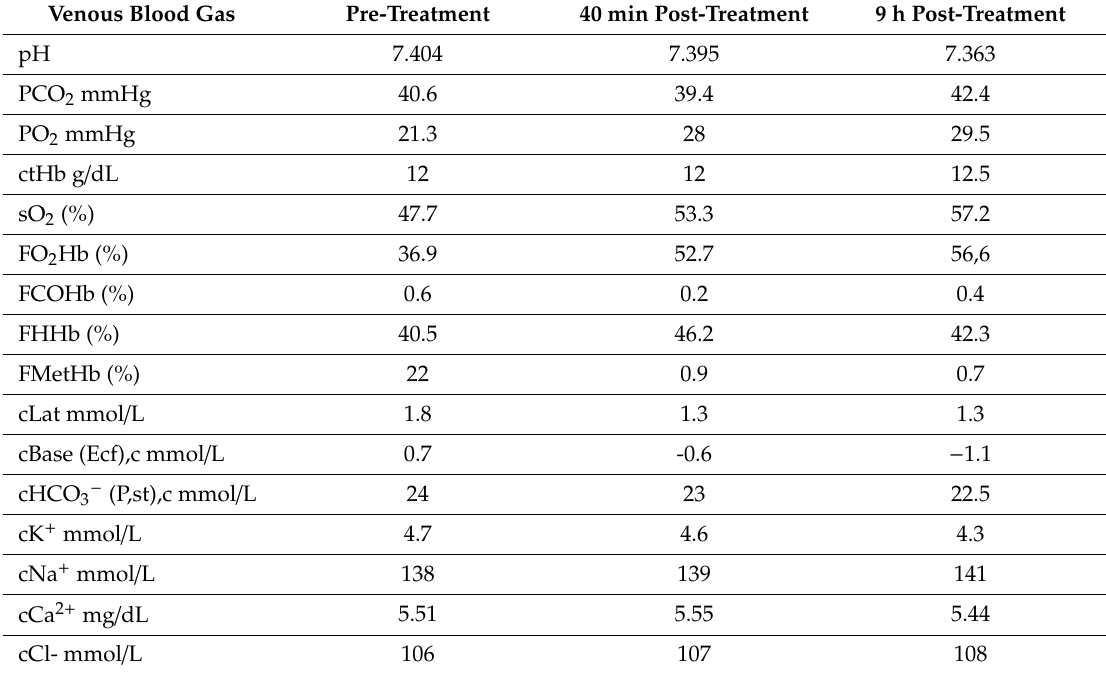
Table 1. Venous gas analysis pre-treatment with methylene blue, 40 min post-treatment, and 9 h post-treatment. Venous Blood Gas Pre-Treatment 40 min